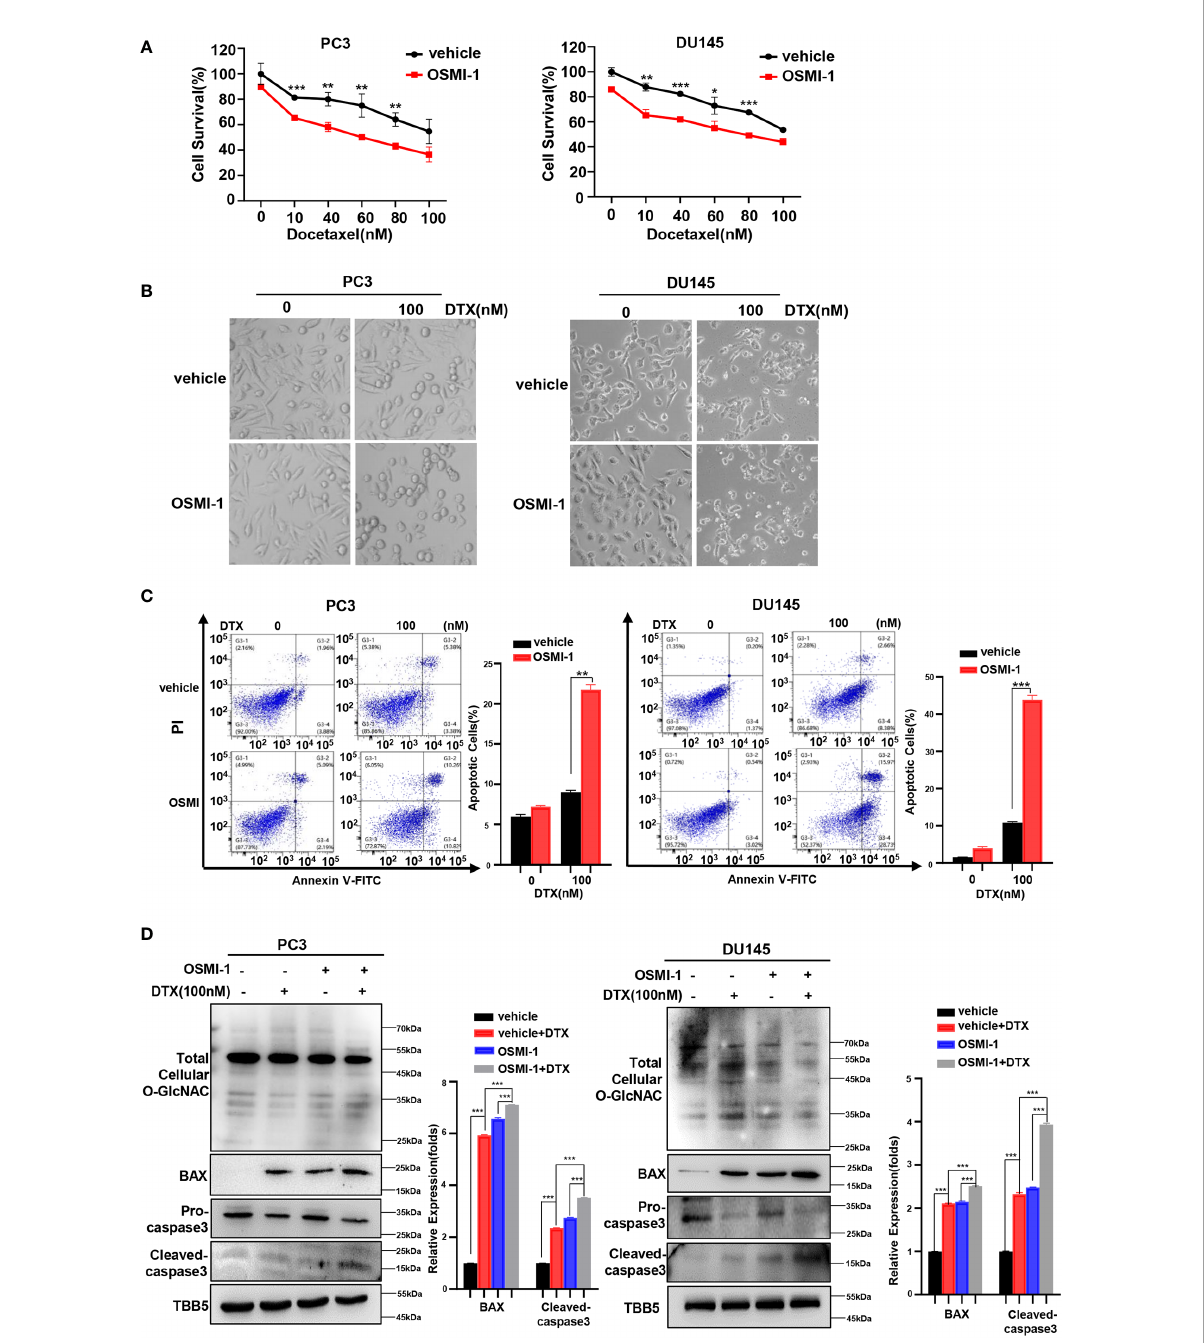
FIGURE 3 OSMI-1inhibition of OGT sensitizes PC cells to docetaxel. (A) Cell survival analysis in PC3 and DU145 cells with different concentration of OSMI- 1 treatment. (B) Morphological analysis of PC3 and DU145 cells treated with OSMI-1, compared with control group. (C) Cell apoptosis was analyzed by fl ow cytometry. (D) Treatment with OSMI-1 enhanced the expression of pro-apoptotic proteins caspase-3 and BAX, and down- regulated the O-GlcNAc levels in PC3 and DU145 cells, compared with control group. *p < 0.05; **p < 0.01; ***p < 0.001 (Student ’ s